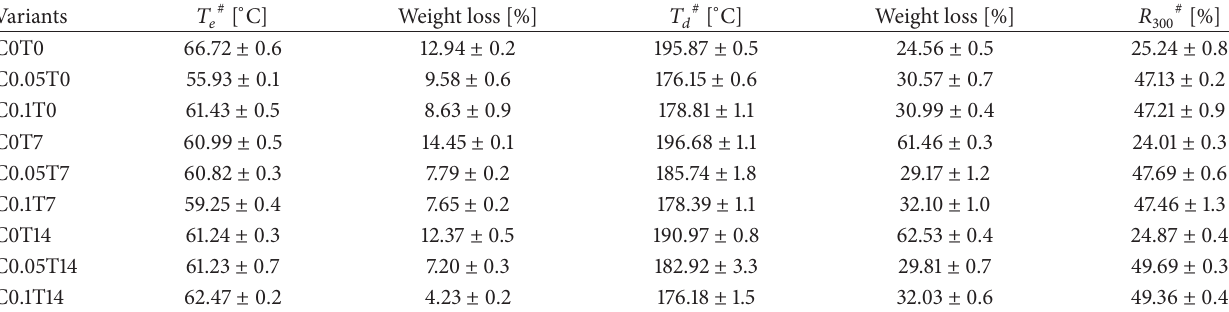
Table 3: Results of thermogravimetric